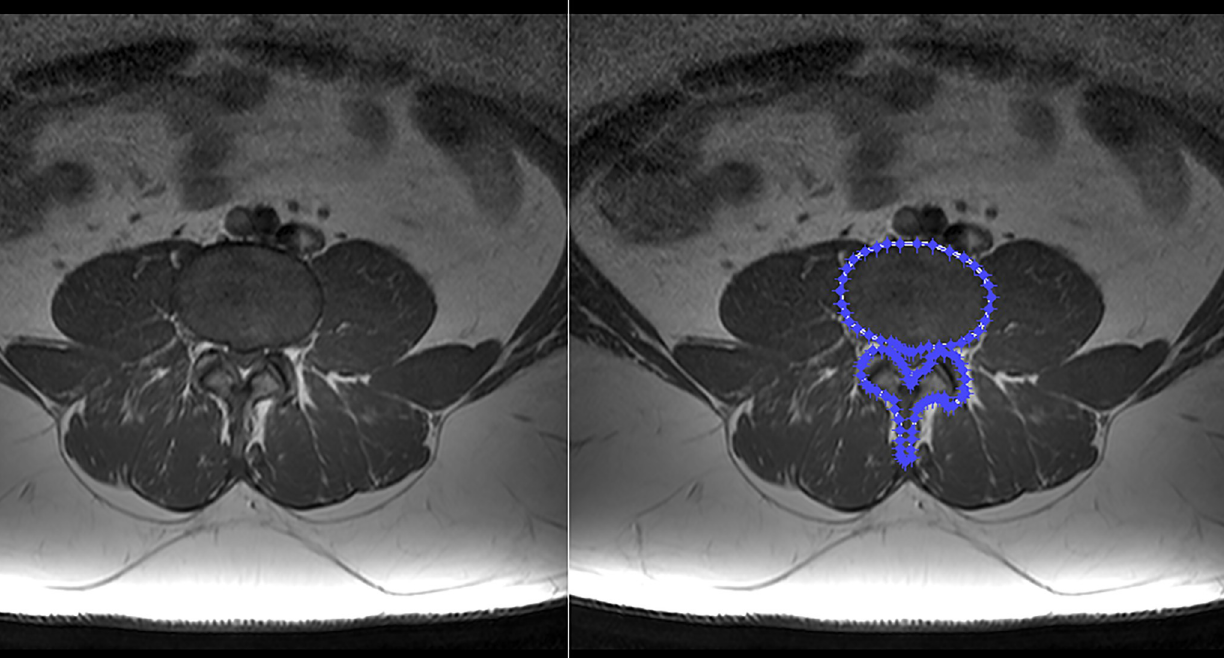
PLOS ONE | https://doi.org/10.1371/journal.pone.0222523 October 10,